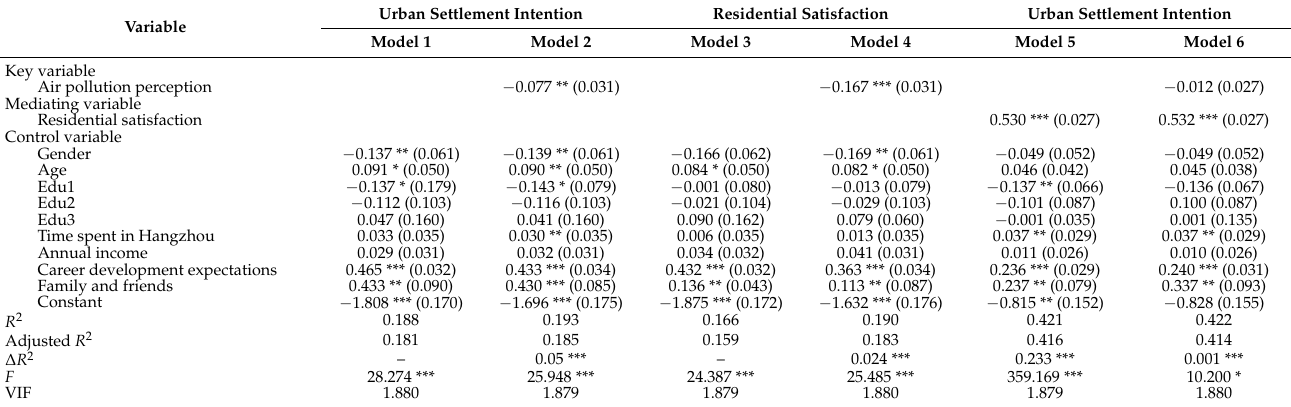
Table 3. Testing main effect and mediating effects of residential